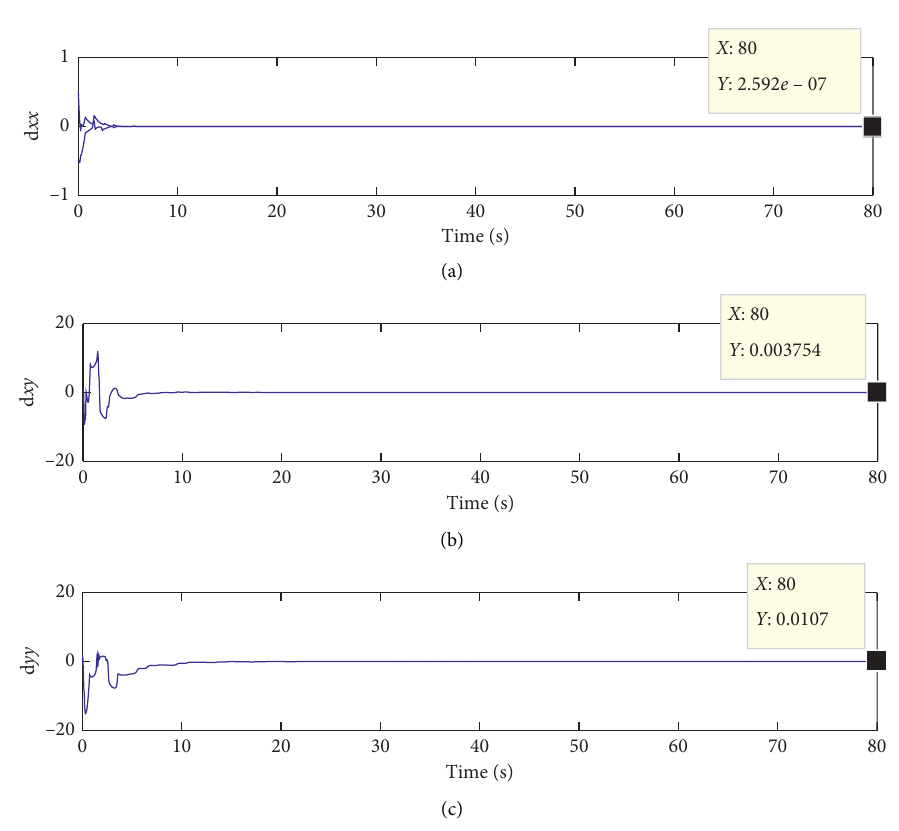
Figure 10: Adaptation of damping coefficients using fractional fast